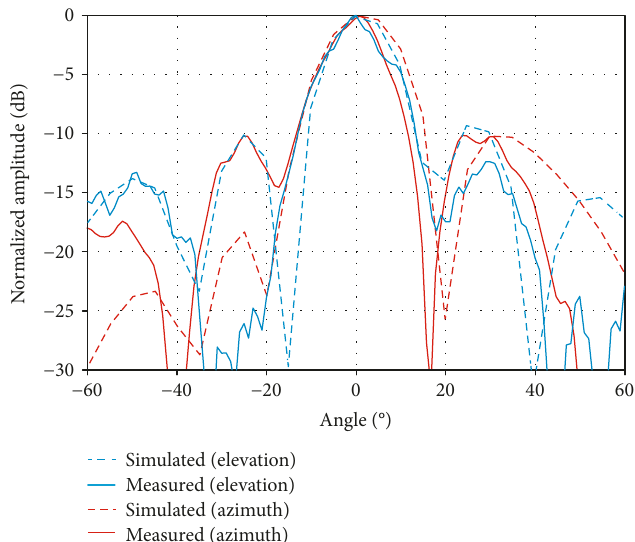
Figure 15: Measured and simulated normalized radiation pattern cuts for the antenna positioning towards the boresight direction at 72.5GHz.